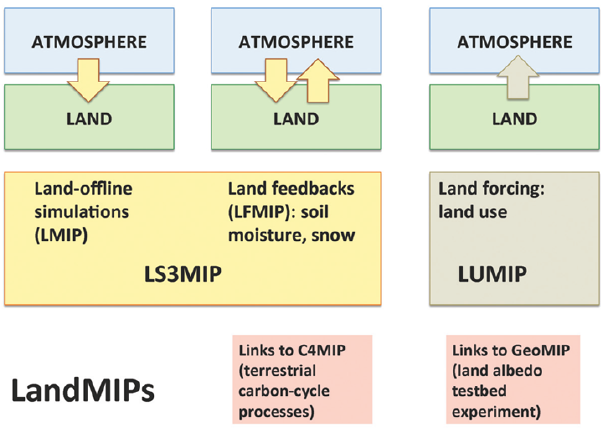
Figure 1. Structure of the “LandMIPs”. LS3MIP includes (1) the offline representation of land processes (LMIP) and (2) the repre- sentation of land–atmosphere feedbacks related to snow and soil moisture (LFMIP). Forcing associated with land use is assessed in LUMIP. Substantial links also exist to C4MIP (terrestrial carbon cycle). Furthermore, a land albedo test bed experiment is planned within GeoMIP. From Seneviratne et al.